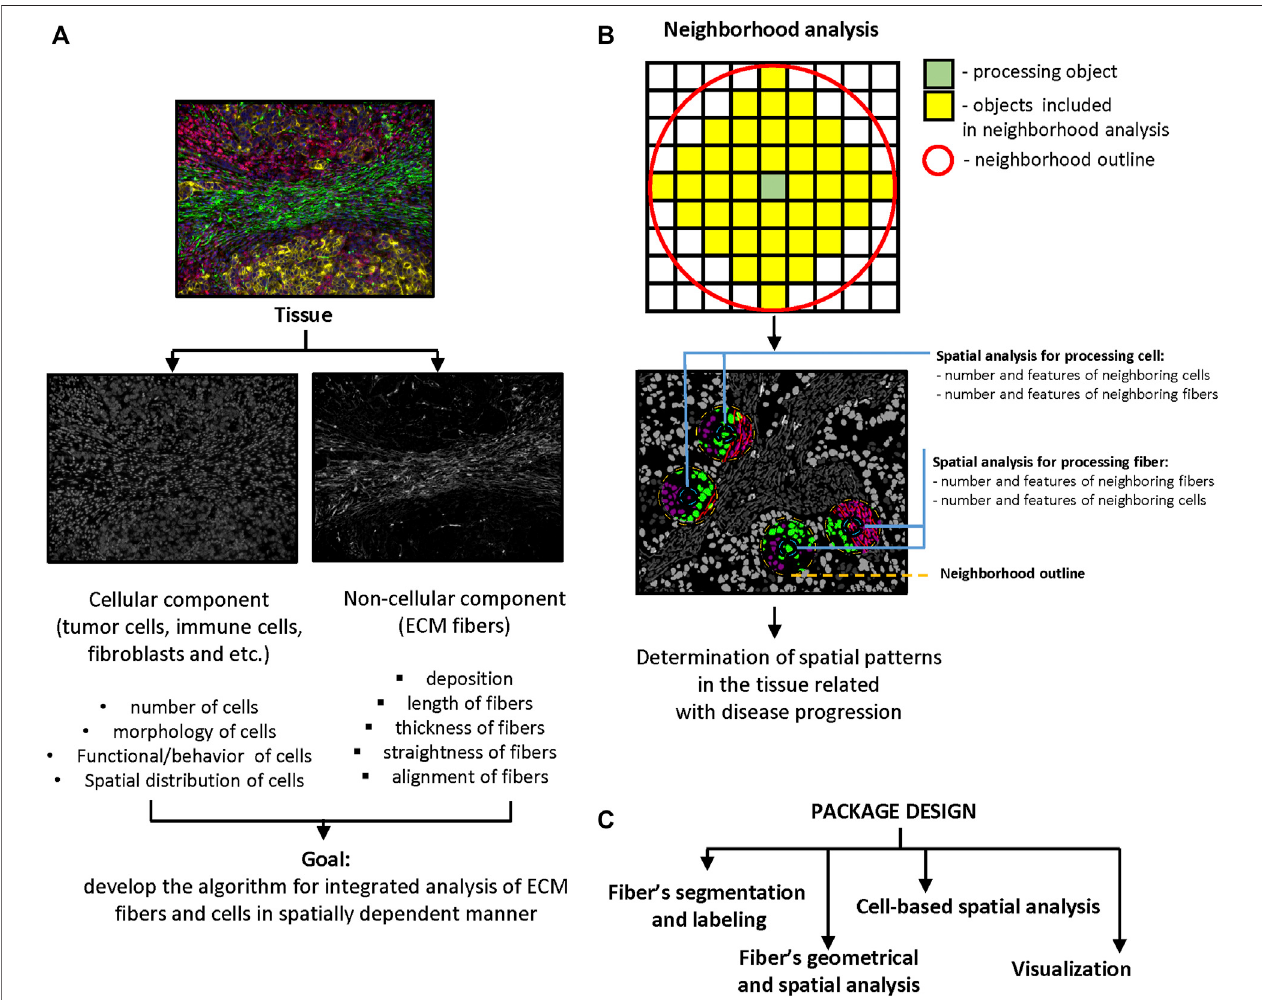
FIGURE 1 | Signi fi cance and package design. (A) Main goal of package design. The scheme demonstrates the idea of combined analysis of cellular and non- cellular components of tumor microenvironment in spatially dependent manner. (B) Principle of neighborhood analysis. Processing object (cell or fi ber) and radius of the neighborhood outline need to be de fi ned fi rst. The features of objects that are localized in the outline analyzed as properties of processing object. The number of neighboring objects and their features need to be calculated for every processing object in the tissue. (C) Package design. Package contains four modules: fi bers segmentation, fi bers geometrical and spatial analysis, cell-based spatial analysis, and visualization.